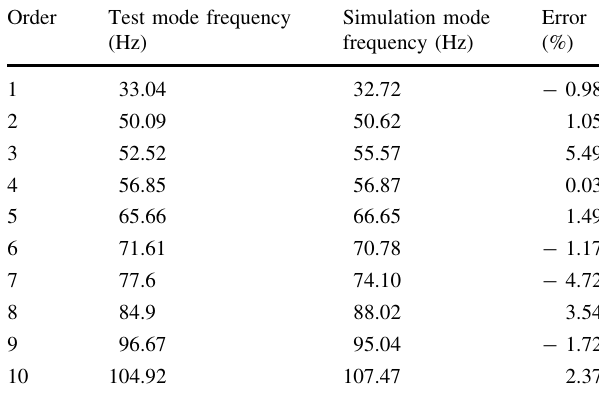
Table 1 Comparison of modal frequency between test and